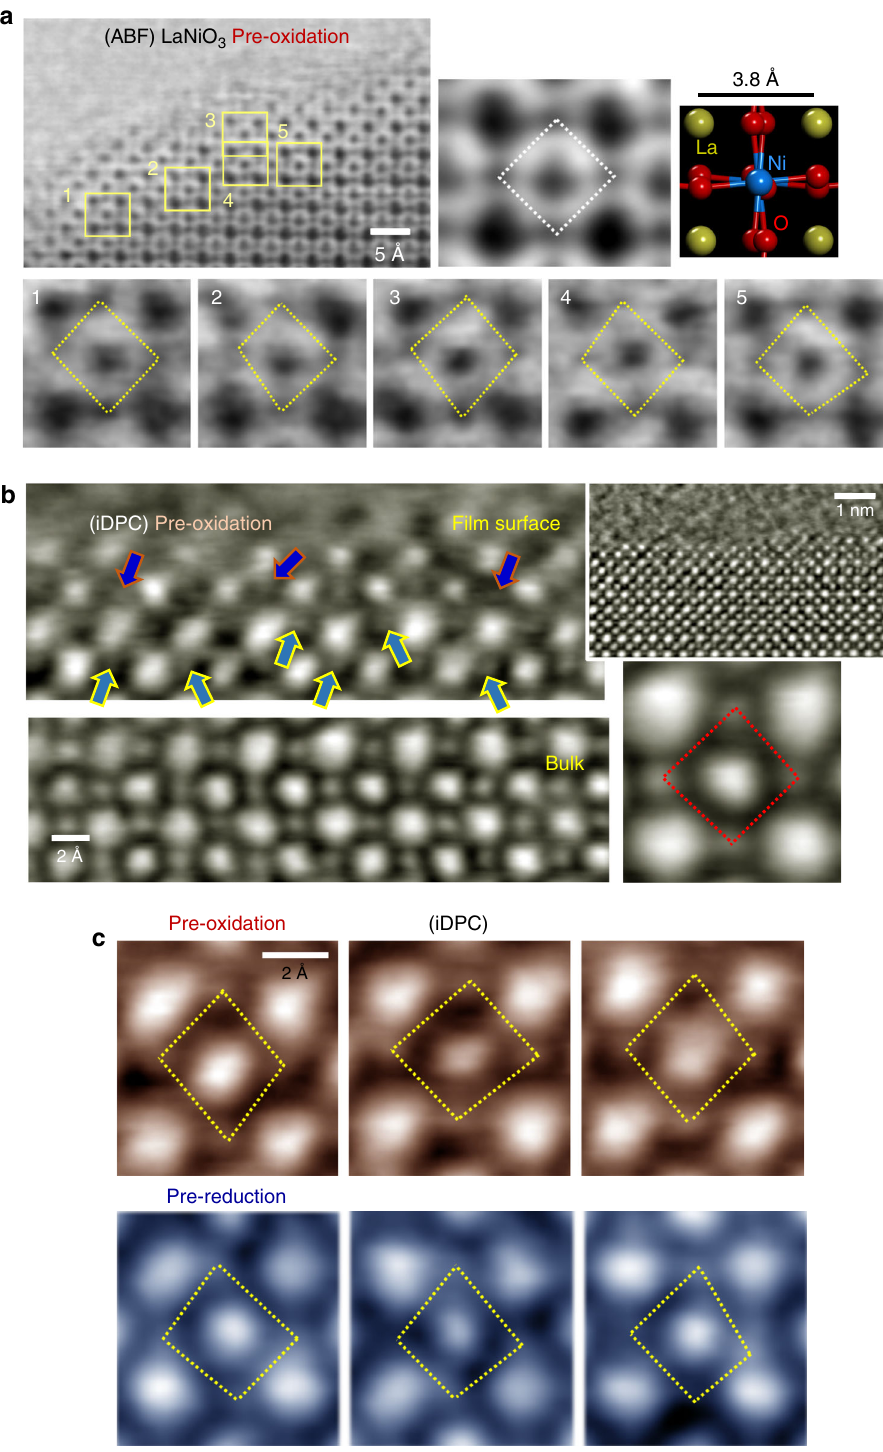
Fig. 5 Atomic-scale direct evidence of oxygen-octahedron distortion. The surface region of the LaNiO 3 fi lms after pre-oxidation and pre-reduction was observed in scanning transmission electron microscopy (STEM). a The unit-cell image with the indication of a white diamond was acquired from the bulk region for reference. A series of annular bright- fi eld (ABF) STEM images are provided in the lower panel for the unit cells denoted by a yellow square in the low-magni fi cation image. As indicated by a yellow rhombus, each oxygen octahedron is substantially distorted. b Integrated differential phase-contrast (iDPC) STEM shows consistent image features. As indicated by arrows on the image captured from the fi lm surface, serious displacement of oxygen atoms is clari fi ed. c iDPC images exemplifying the oxygen displacement are demonstrated for both pre-oxidation and pre-reduction